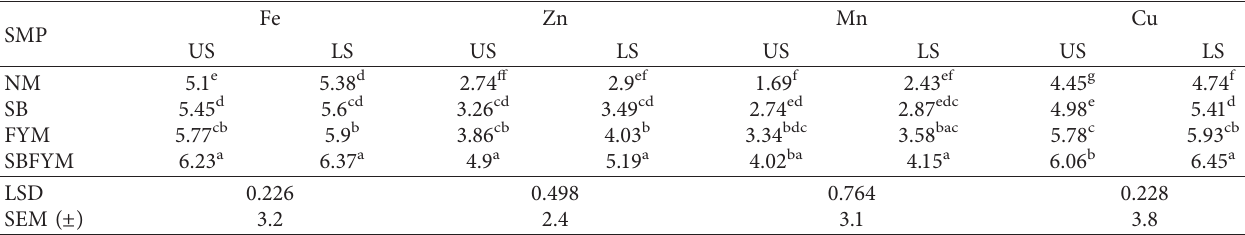
Table 9: The interaction effect of soil management practices and slope ranges on micronutrient cations in soils of Mawula watershed (mg · kg − 1 ).